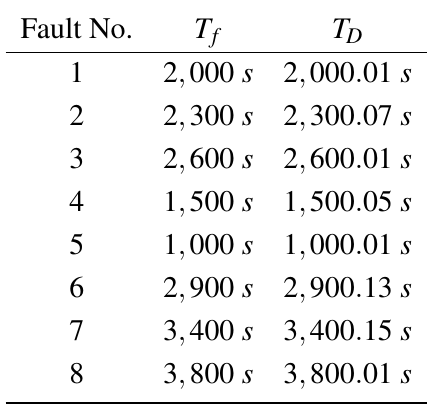
Table 7. Summary of fault detection results using auxiliary